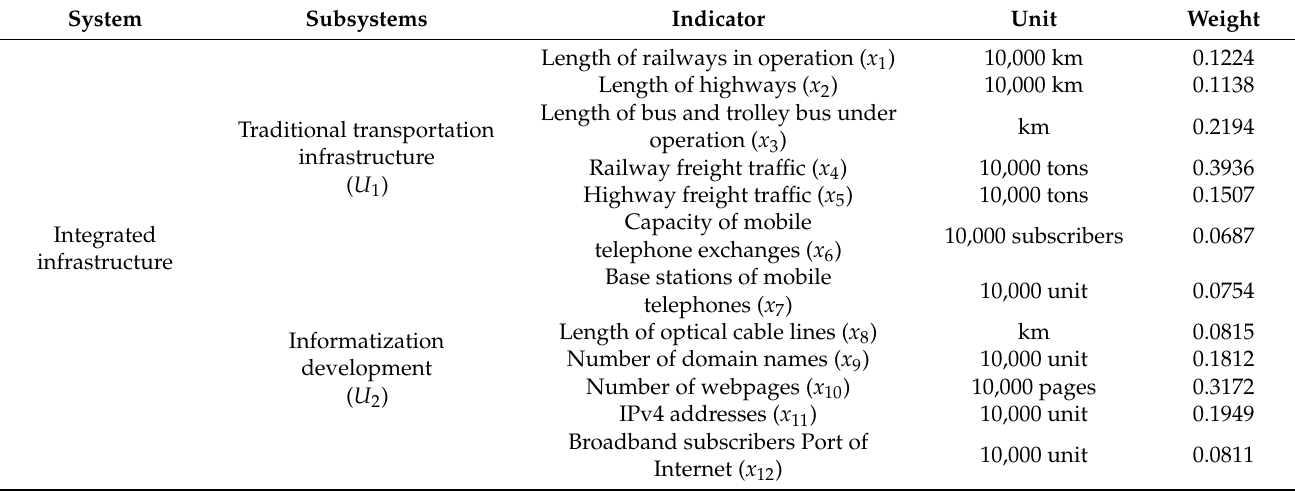
Table 1. The index system for assessing the integrated infrastructure.